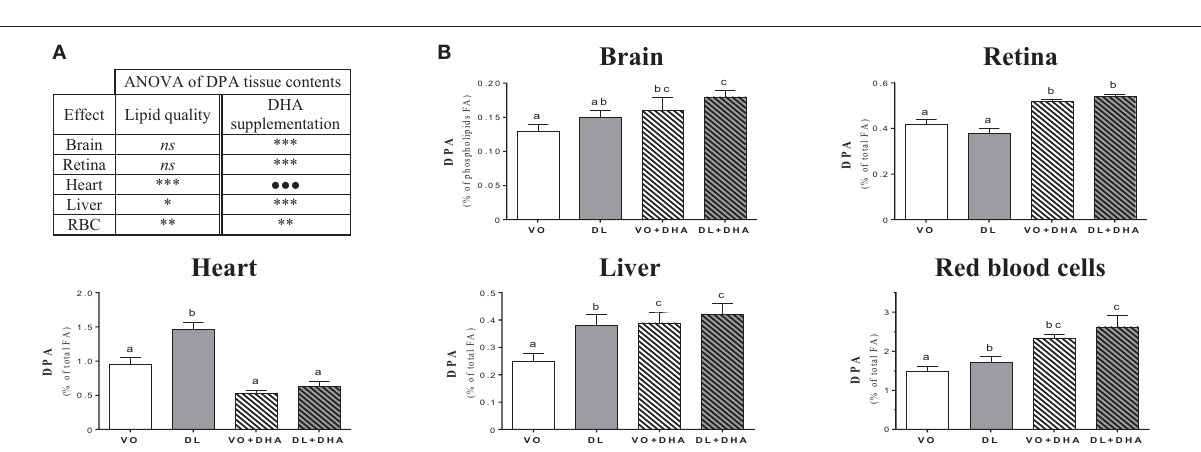
FIGURE 4 | (A) Overall lipid quality (LQ) effect and DHA supplementation (S) effect of the n-3 docosapentaenoic acid (n-3 DPA) proportions in brain, retina, heart, liver and red blood cells (RBC) of rats fed the vegetable oil blend diet (VO) or the vegetable oil and dairy lipid blend diet (DL), not supplemented or supplemented with 0.5% DHA (VO + DHA and DL + DHA). The significance of the two effects was assessed by two-ways ANOVA (* p < 0.05, ** p < 0.01, *** p < 0.001). *Represents globally an increase in favor of the DL groups for the LQ effect, and in favor of the lots supplemented with DHA for the S effect. ns , not significant. (B) Proportions of DHA in tissues. Values are mean ± SEM. Different superscript letters indicate significant differences for multiple comparisons ( p <